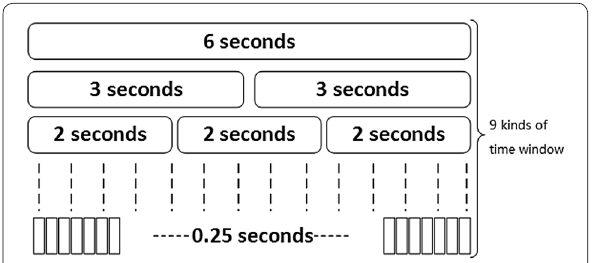
Fig. 1 Block diagram of window